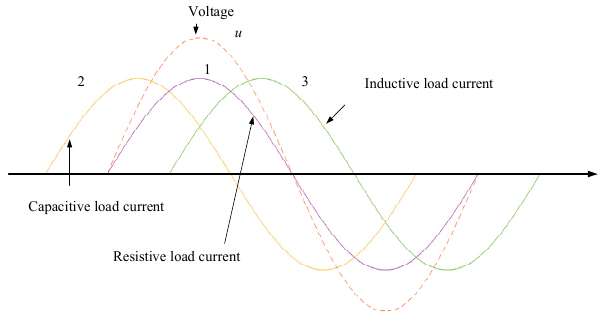
Figure 3. Current of the linear load.